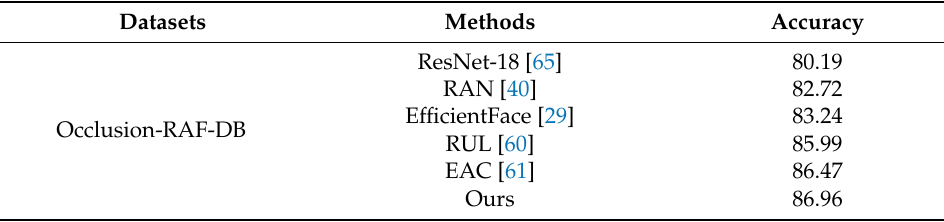
Table 5. Comparison with state-of-the-art methods on occlusion-RAF-DB.